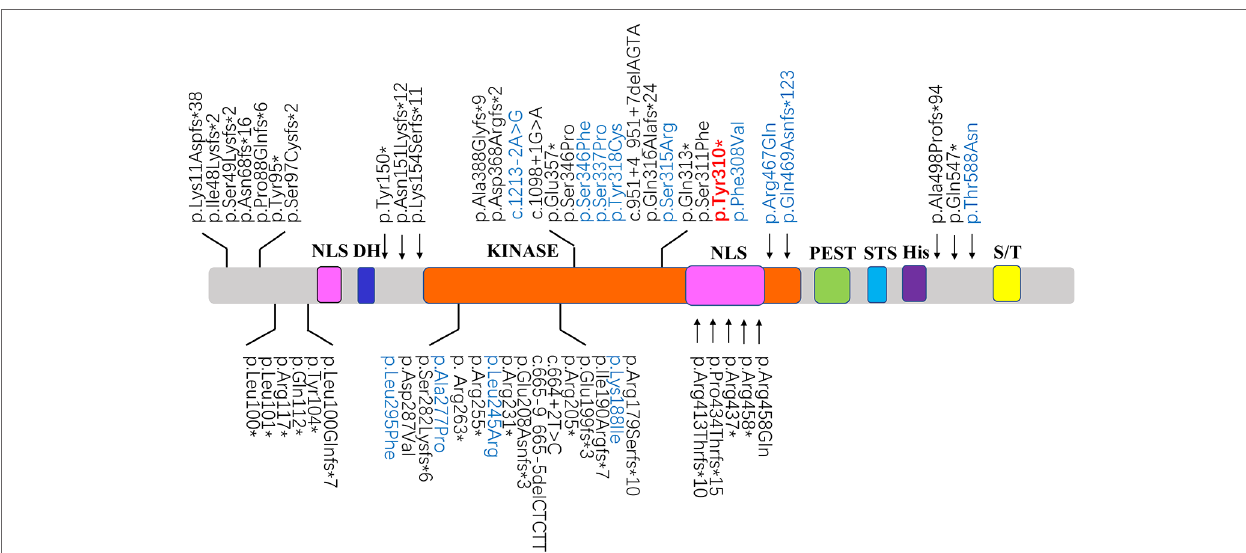
FIGURe 4 | Schematic diagrams showing structure of DYRK1A. The recently identified pathogenic variants and likely pathogenic variants were shown in black and blue, respectively. The position of the mutation identified in this study are shown in red. NLS, nuclear localization signal; DH, DYRK homology domain; KINASE, protein kinase domain; PEST, domain enriched in proline, glutamic acid, serine, and threonine residues; STS, the speckle-targeting signal; His, histidine repeats; S/T, serine and threonine-rich region.